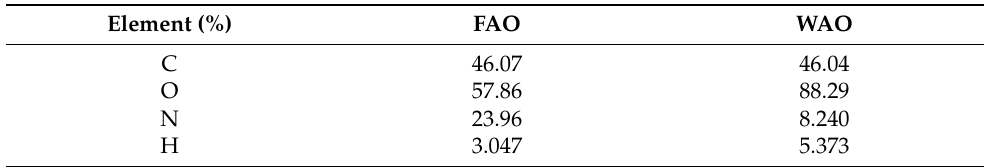
Table 1. C, N, O and H contents in the FAO and